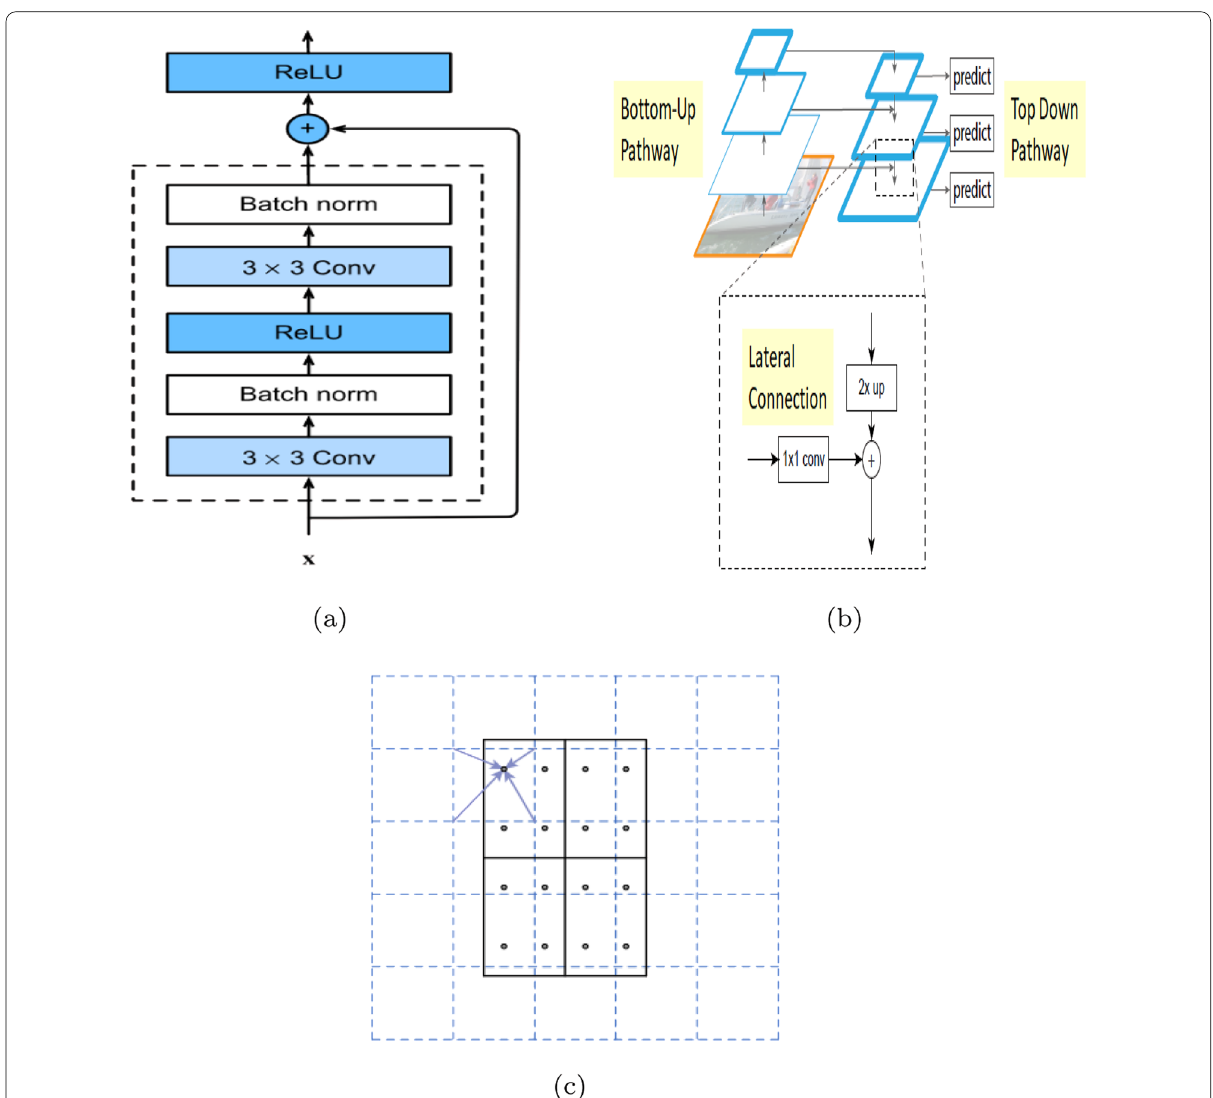
Fig. 8 An overview of the following: a ResNet architecture (obtained from He et al. (2016)), b FPN architecture (obtained from Lin et al. (2016)) and c RoIAlign (obtained from He et al.